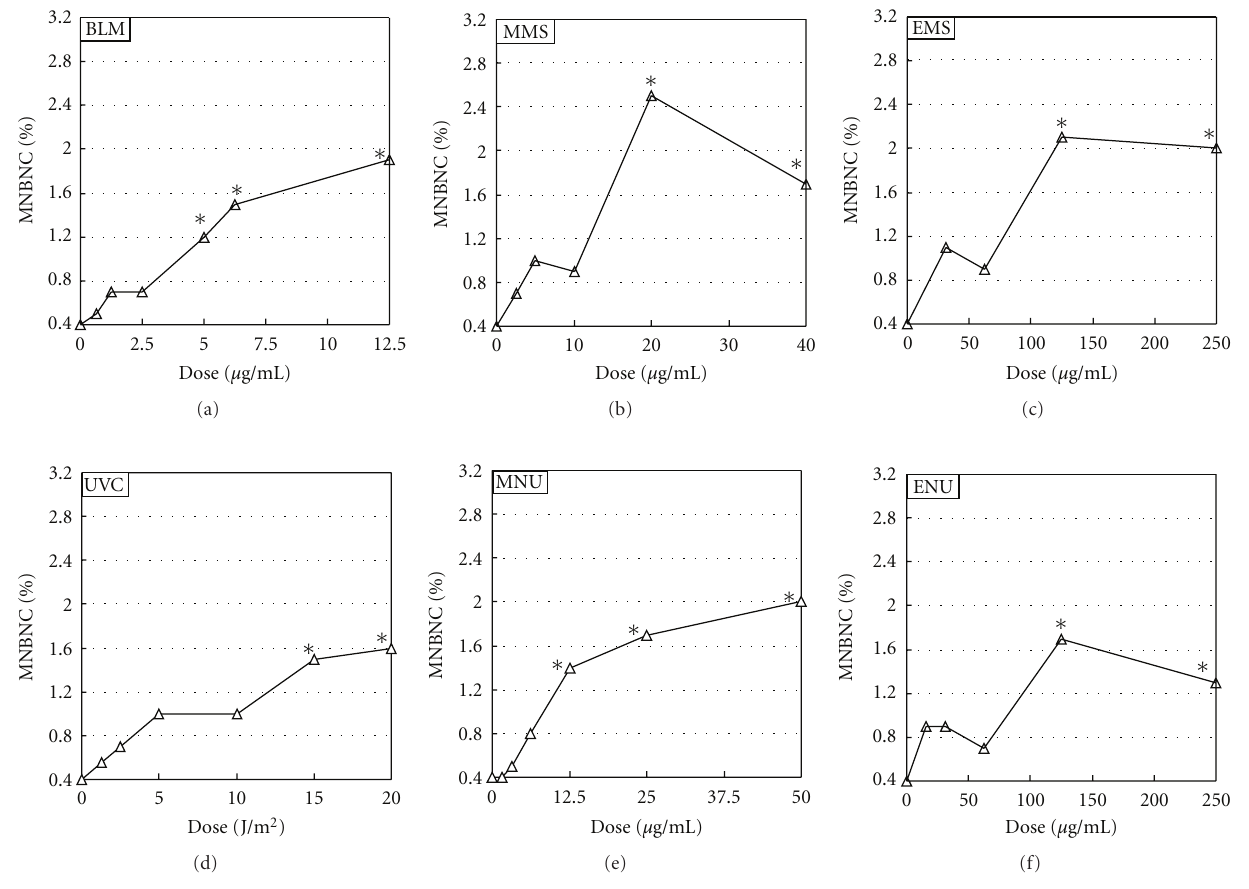
Figure 3: MN test in TK6 cells. TK6 cells were exposed to each chemical mutagen for 2h or irradiated with UVC and were incubated for 24h with cytochalasin B, and then slides for MN test were prepared. Reproducibility was ascertained by three independent experiments and representative data are shown. ∗ Significant di ff erence from untreated control: P < . 05.